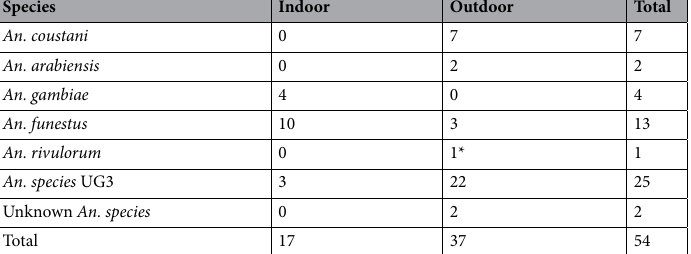
Species Indoor Outdoor